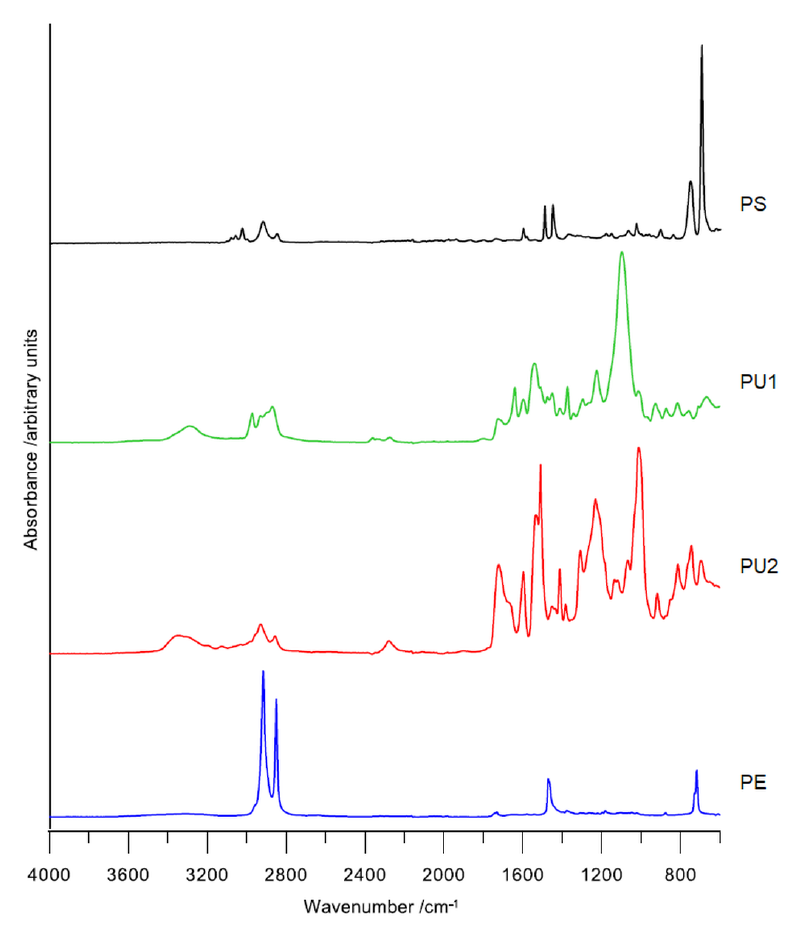
Figure 2. FT-IR spectra for plastics used in the experiments. PS—polystyrene (Styrofoam), PU1—polyurethane foam (kitchen sponge), PU2—polyurethane foam (building thermal insulator), PE—polyethylene foam (packaging